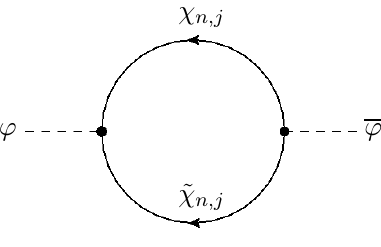
Figure 4. Fermionic contribution to the Wilson line mass with